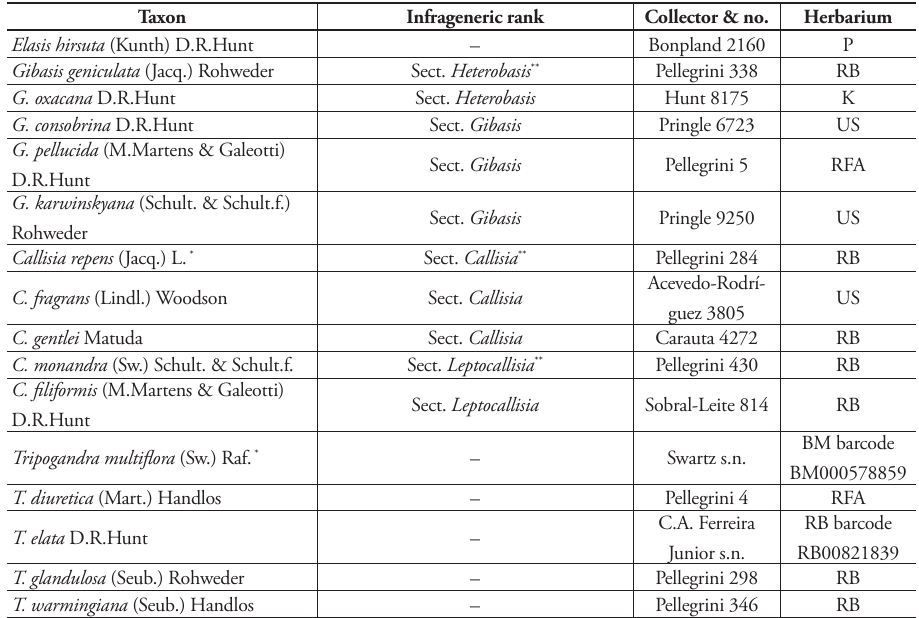
Table 2. Primary literature sources for information used in the phylogenetic analysis.